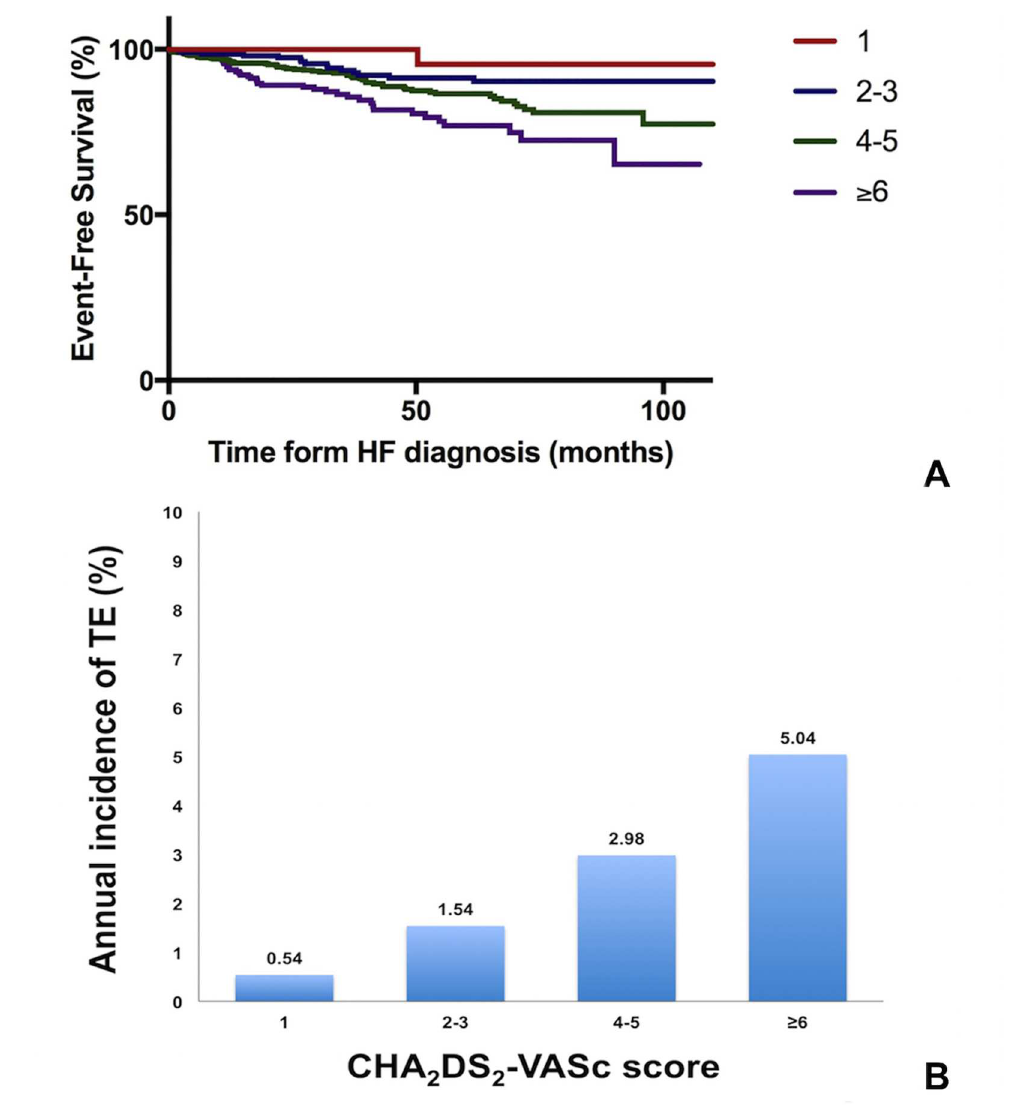
Fig 2. Risk of thromboembolic events among heart failure patients in sinus rhythm according to their CHA 2 DS 2 -VASc score. (A) Kaplan-Meier curves for thromboembolic event-free survival. Log-rank: 19.714. P < 0.001.(B) Annualincidenceof thromboembolic events. CHA 2 DS 2 -VASc = 1: 0.54% per year (95% CI 0.45– 0.67); CHA 2 DS 2 -VASc = 2–3: 1.54% per year (95% CI 1.41–1.70);CHA 2 DS 2 -VASc = 4–5: 2.98% per year (95% CI 2.81–3.18);